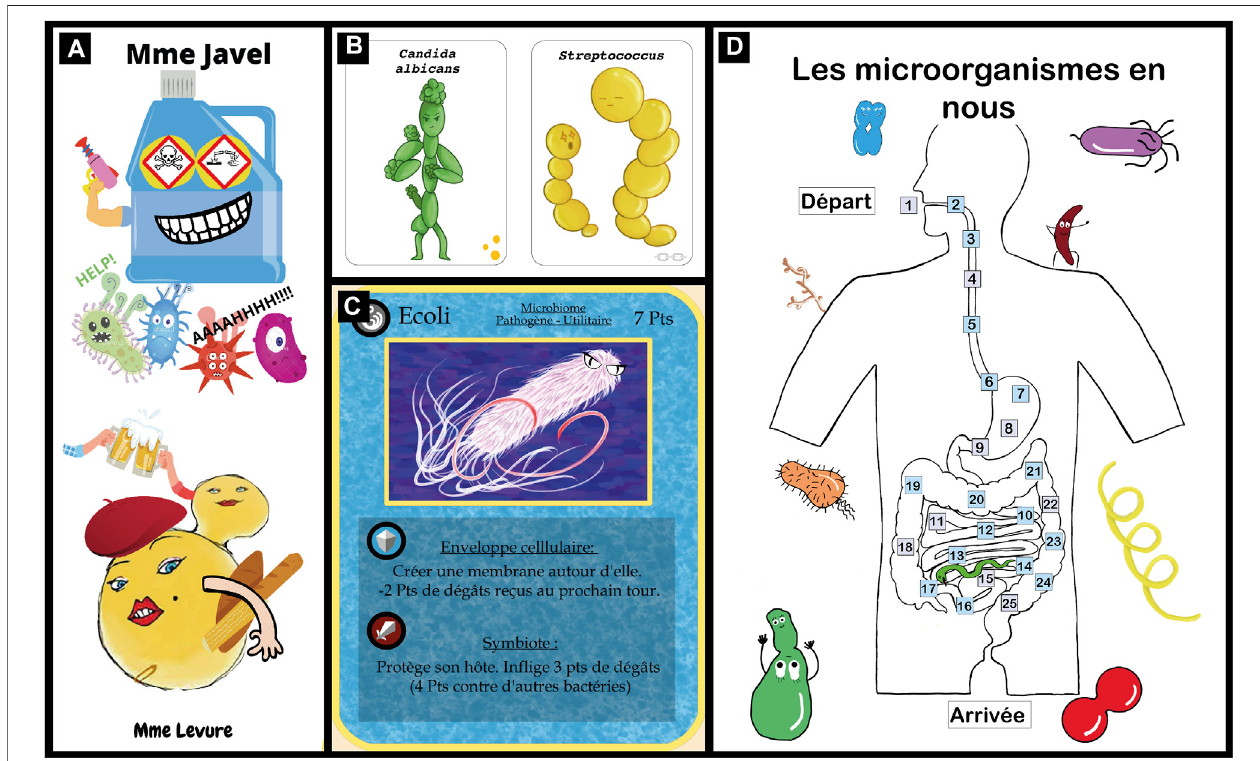
FIGURE2| Examplesofthematerialcreatedbythestudentsin2021todeveloptheiractivities (A) Mr.-Mrs.comiccharacters(originallyfromkidsbookswrittenand illustrated by Roger Hargreaves) designed here by the students to introduce the topic of microbiology (B) Card illustrating microorganisms that can be responsible of diseases (C) Card to play a battle Pokemon-like game with some “ attack ” and “ defence ” points unique to each microbe (D) Board game with physical challenges and questions about microbes.